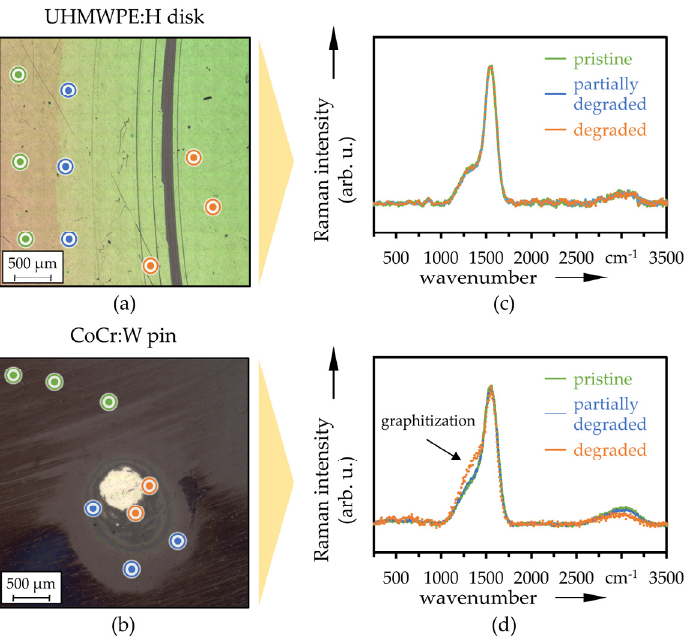
Figure 11. LM images with Raman measurement positions on the disk ( a ) and pin ( b ) as well as averaged Raman spectra ( n = 3) at pristine, partially degraded and degraded positions of UHMWPE:H ( c ) and CoCr:W ( d ).